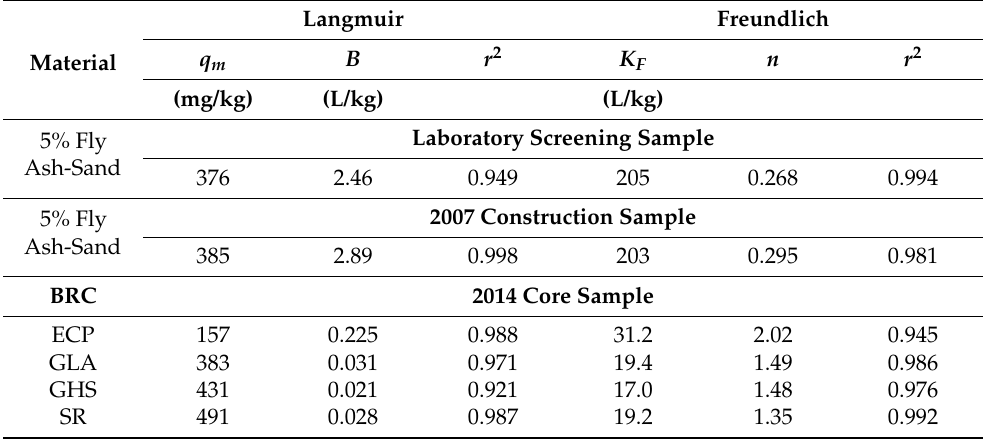
Table 2. Langmuir and Freundlich phosphorus isotherm parameters obtained for initial screening, 2007 construction, and 2014 cores from four BRC [20]. Langmuir Freundlich q m Material Laboratory Screening Sample Ash-Sand